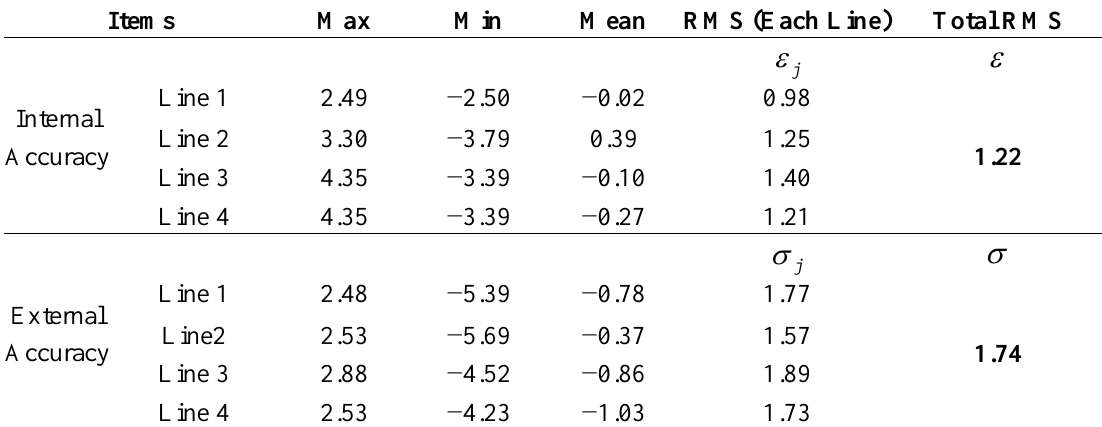
Figure 14. Filtered gravity disturbances with 300 s FIR filter. Table 3. Accuracies of 300 s FIR filtered gravity disturbances (Units: